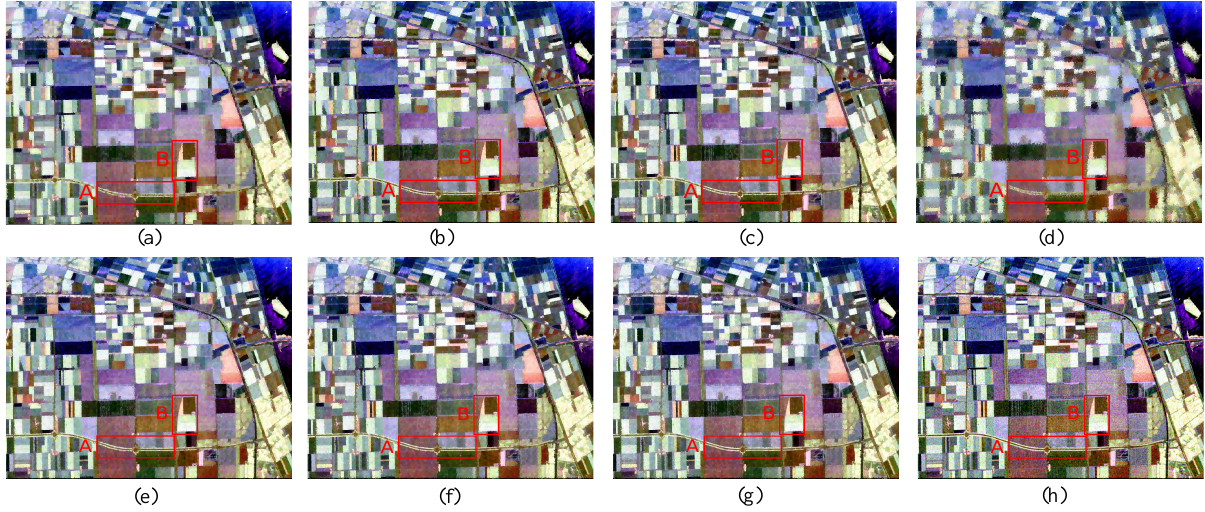
Figure 14. Qualitative evaluation results of data set 1. ( a ) POL-SLIC. ( b ) POL-LSC. ( c ) POL-HLT.